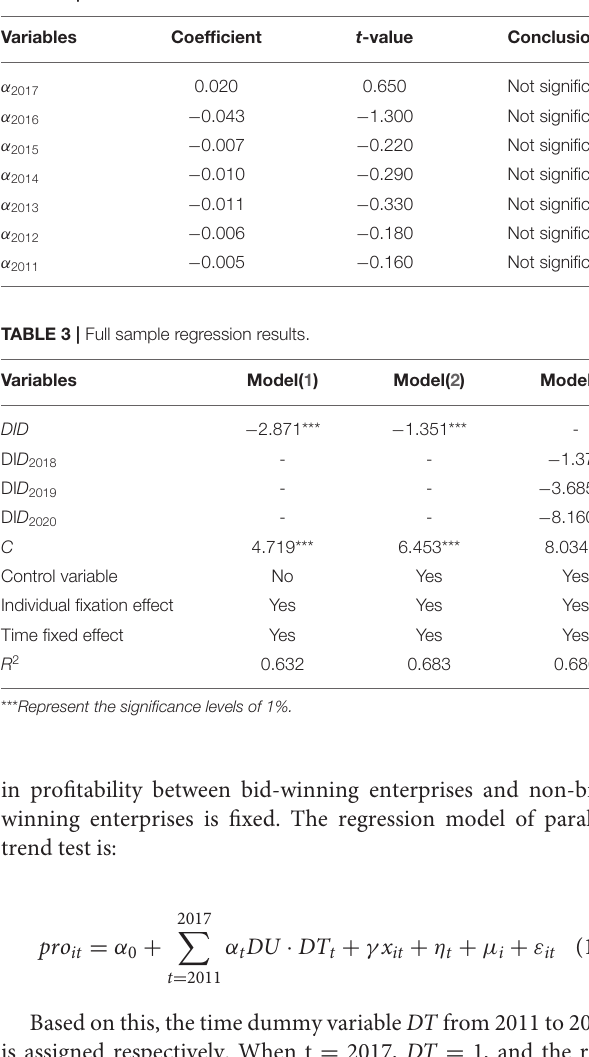
TABLE 2 | Parallel trend test.